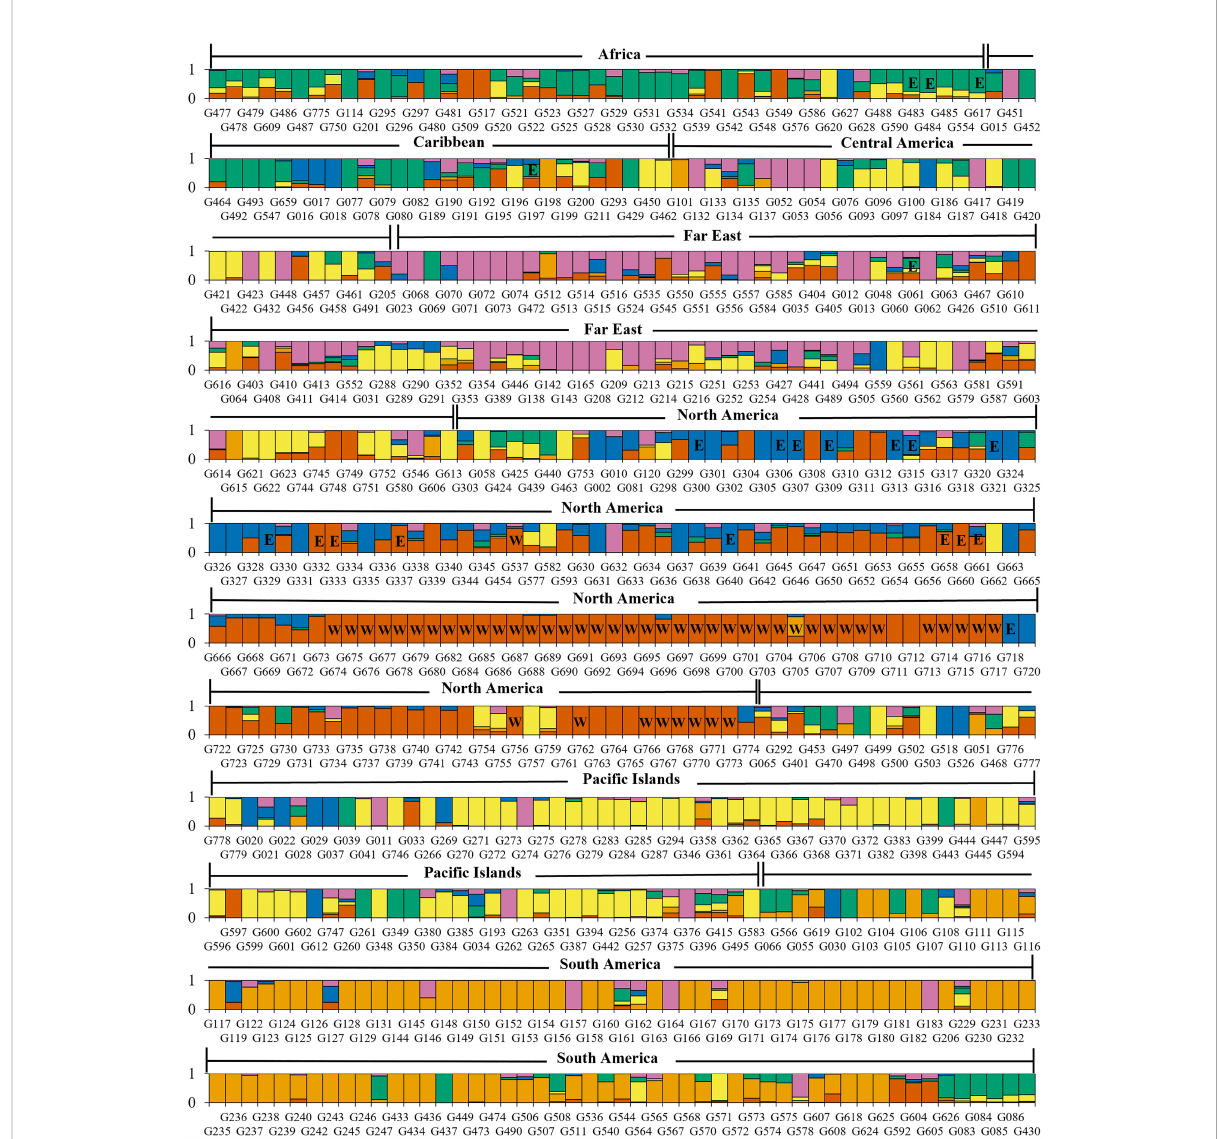
FIGURE 4 Barplot of Bayesian clustering assignments of 604 sweetpotato ( Ipomoea batatas ) accessions for K=6. Assignment probabilities are shown for the six genetic groups identi fi ed where C1 is red, C2 is orange, C3 is yellow, C4 is green, C5 is blue, and C6 is pink. Accession bars labeled “ E ” have been identi fi ed as having Meloidogyne enterolobii resistance and accession bars labeled “ W ” are members of the